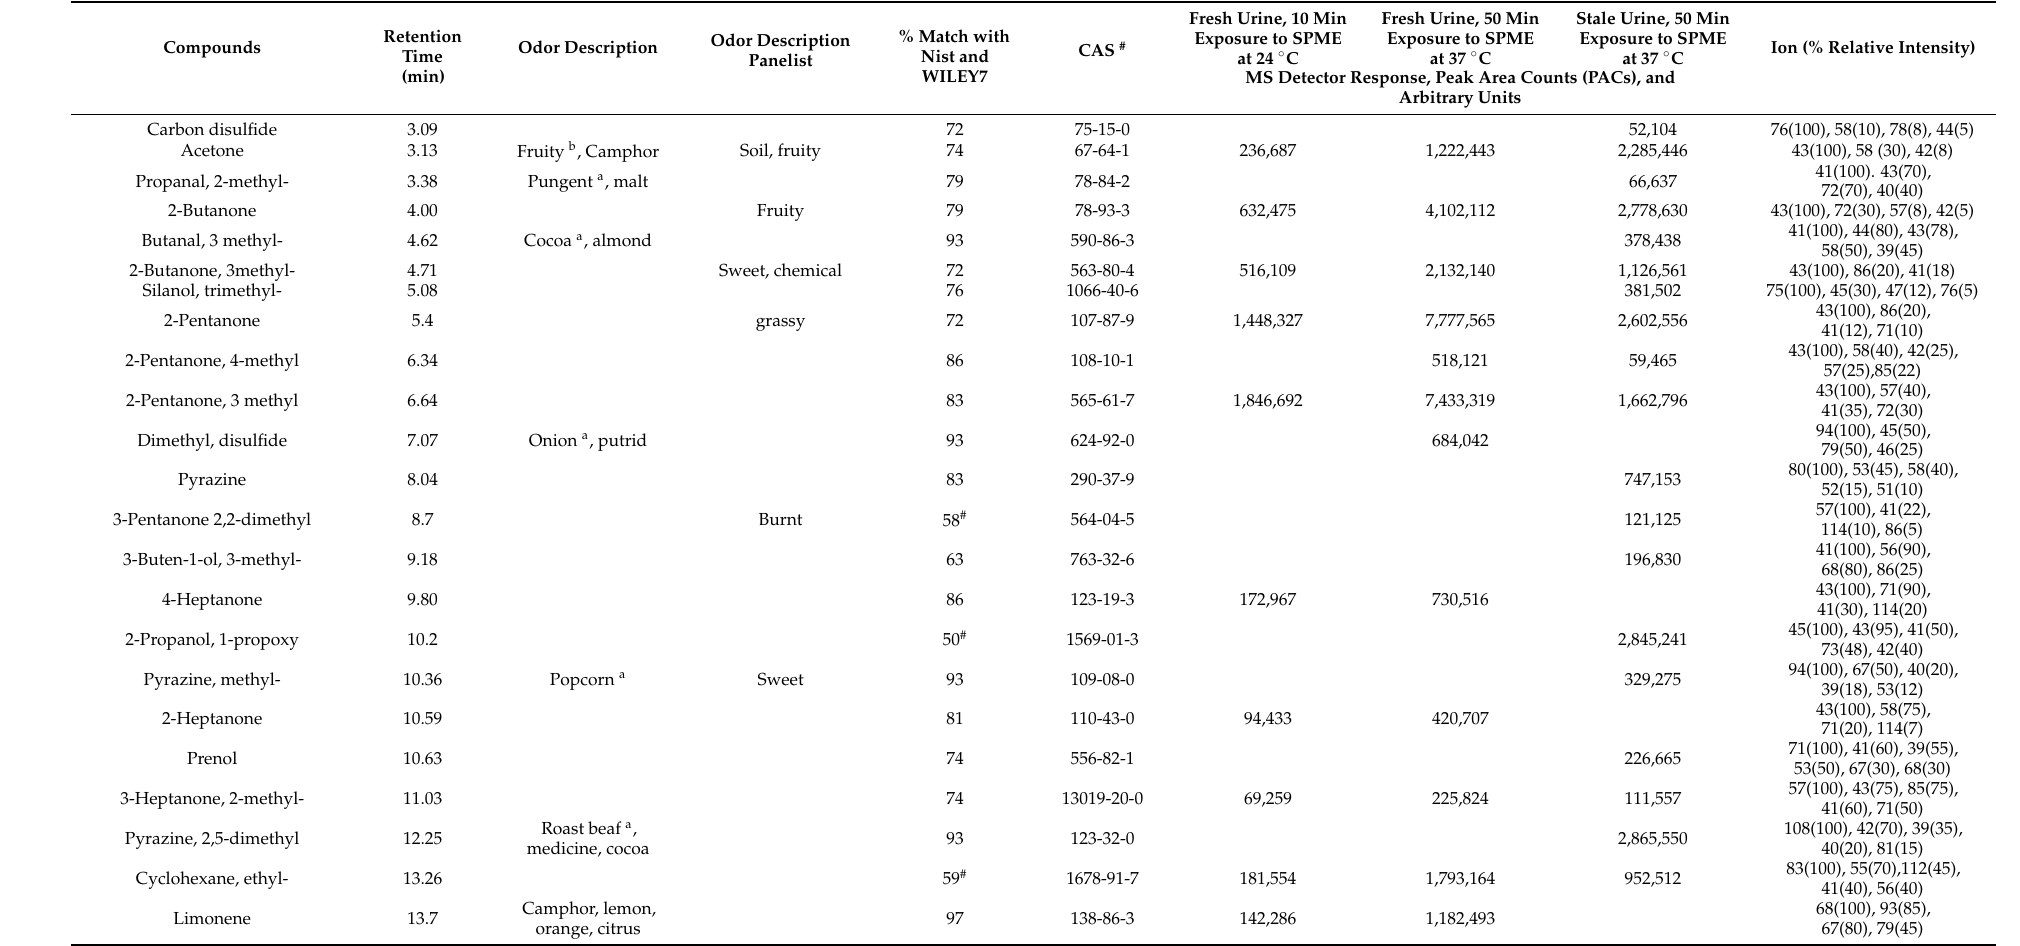
Table 2. Compounds identified in the headspace of fresh and stale cat urine on short and long exposures to the SPME